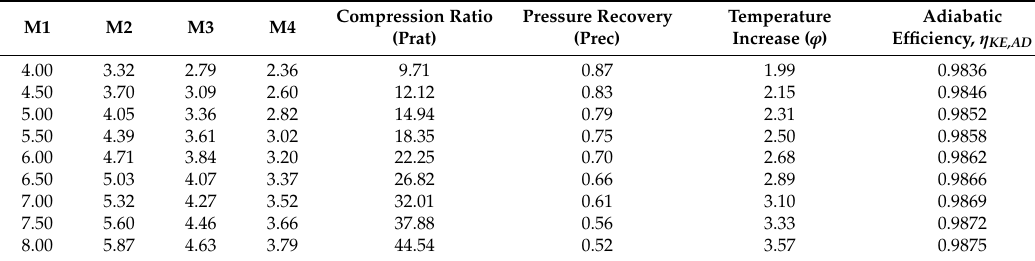
Table 3. Theoretical calculations for three ramp inlet.